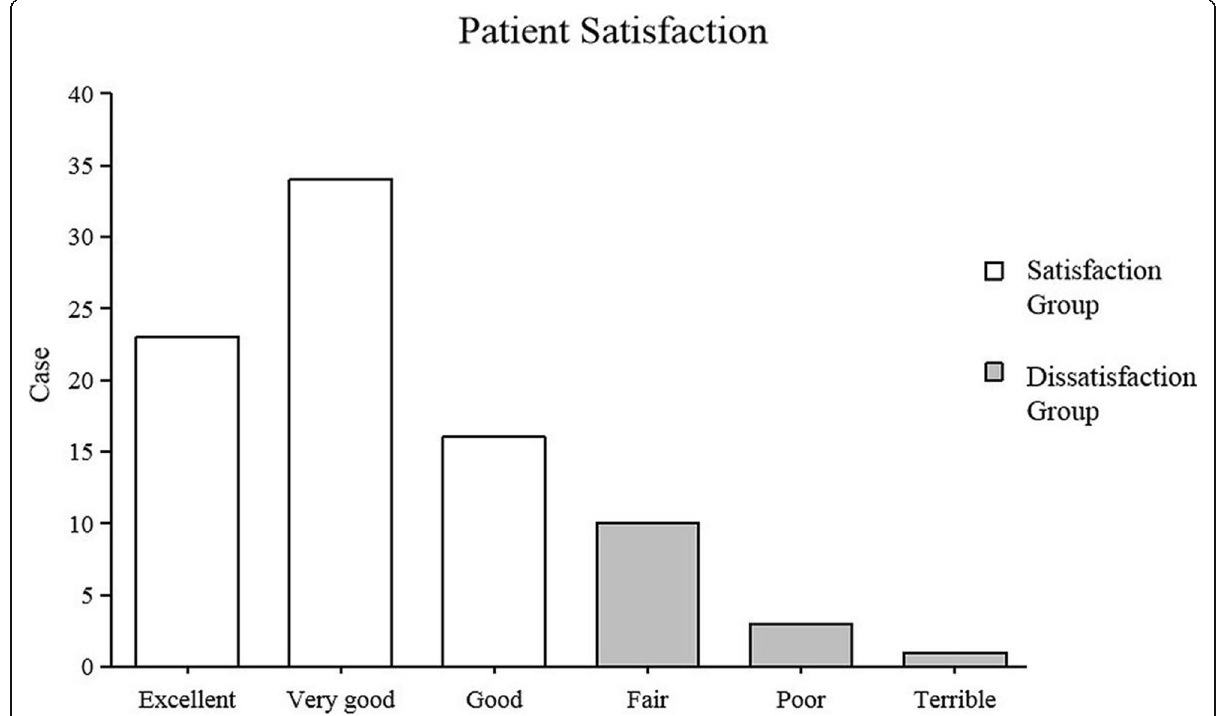
Fig. 3 Patient satisfaction at the last follow-up. Of the 87 cases, 23 (26.4%) felt excellent, 34 (39.1%) felt very good, 16 (18.4%) reported good, 10 (11.5%) fair, 3 (3.4%) poor and 1 (1.1%) terrible